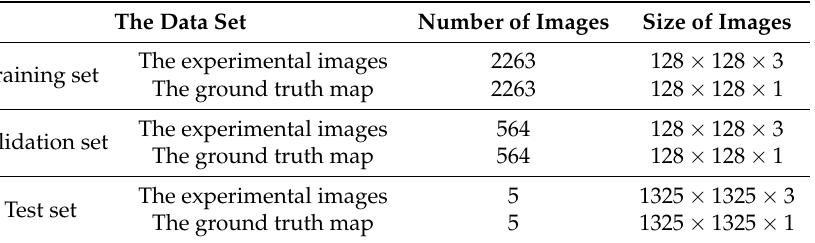
Table 2. Training, validation and test set of the experiments.